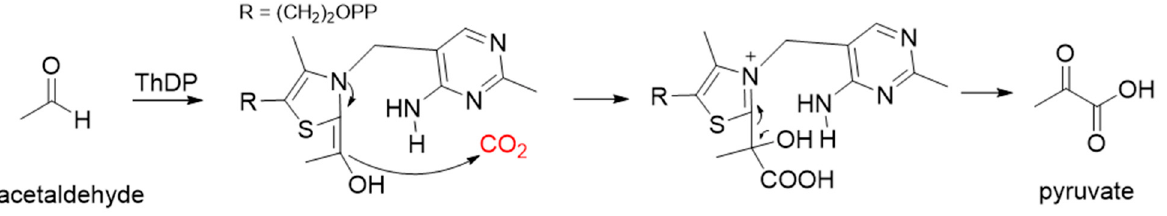
Figure 7. The catalytic mechanism of pyruvate decarboxylase